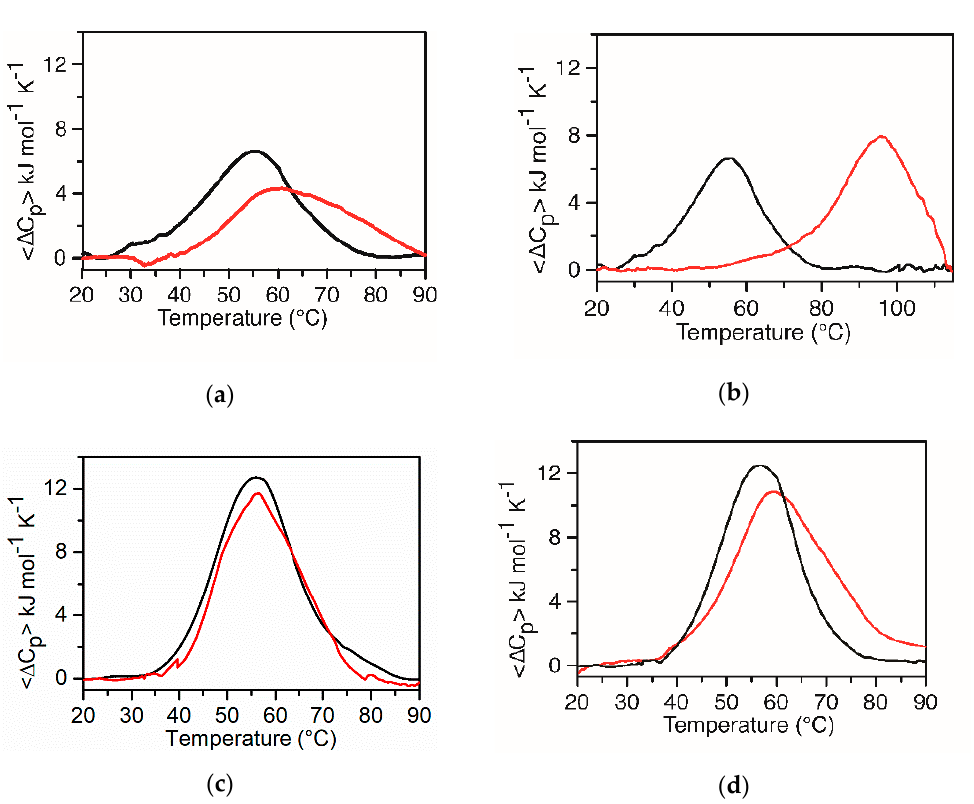
Figure 6. DSC profiles of KRAS 22RT ( a ) and KRAS 32R ( c ) in the absence (black line) and presence (red line) of 1 equivalent of TMPyP4. DSC profiles of KRAS 22RT ( b ) and KRAS 32R ( d ) in the absence (black line) and presence (red line) of 1 equivalent of BRACO-19. The buffer solution was 20 mM KH 2 PO 4 /K 2 HPO 4 with 60 mM KCl and 0.1 mM EDTA at pH